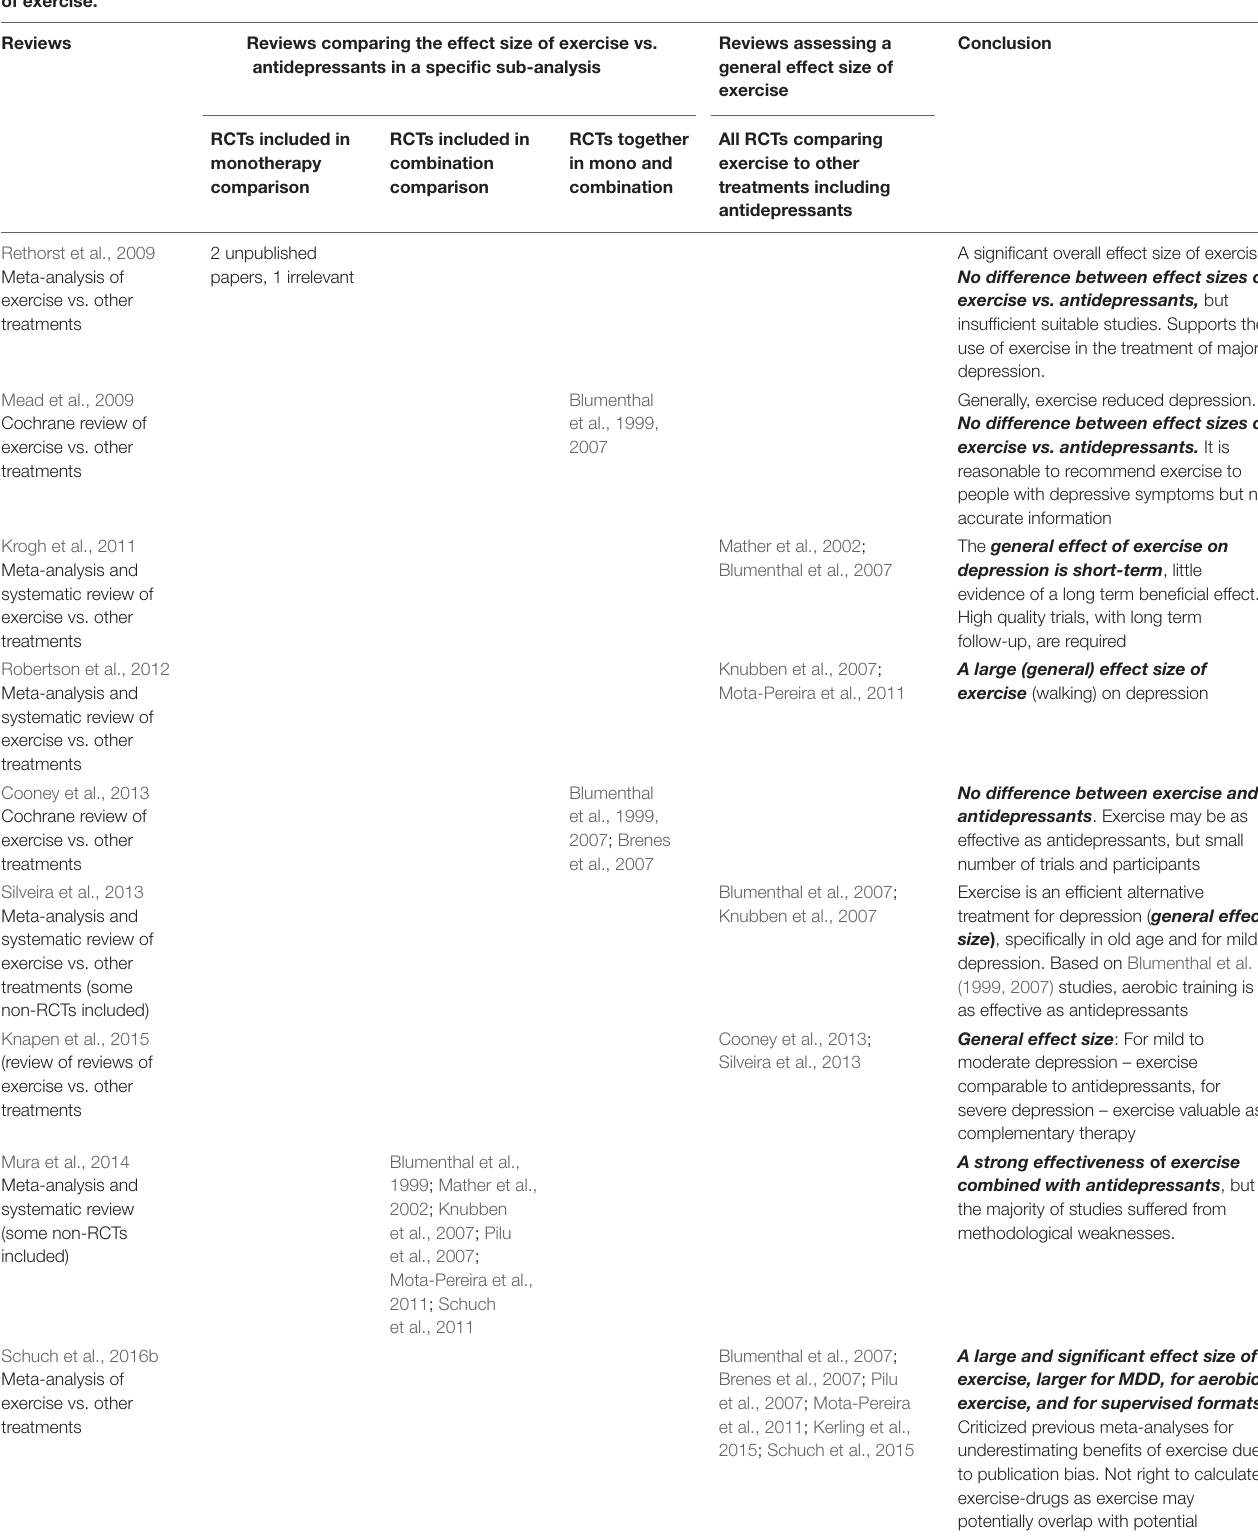
TABLE 2 | A map of RCTs in reviews comparing exercise to antidepressants in the treatment of depression, and the conclusions regarding the effect size of